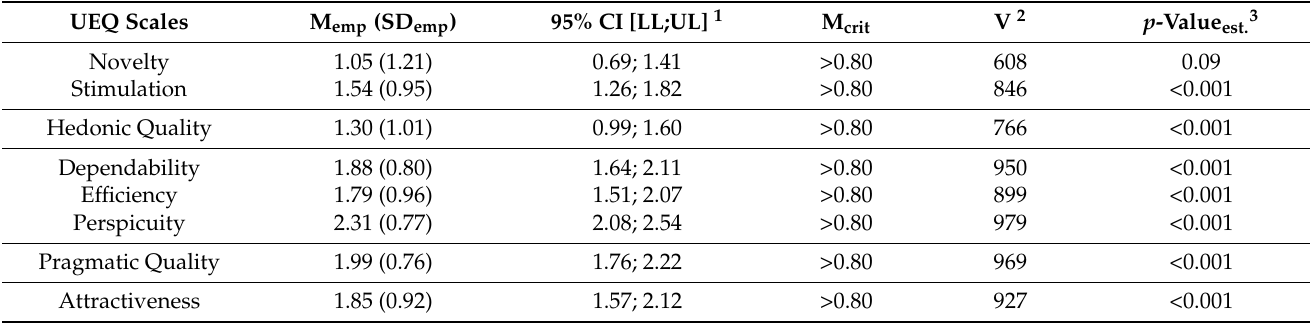
Table 5. UEQ ratings of vStop HMI prototype by participants of the second user study (N = 44). UEQ Scales M emp (SD emp ) 95% CI [LL;UL] 1 M crit V 2 p -Value